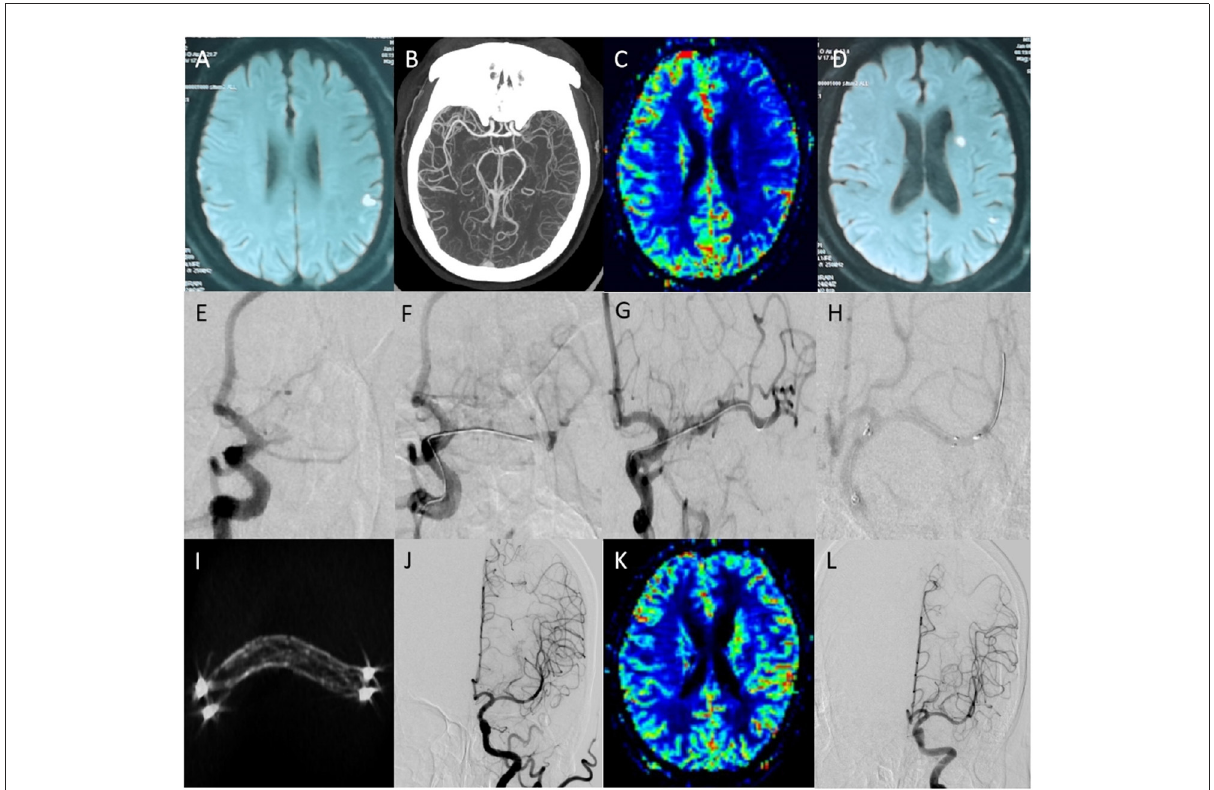
FIGURE1 Clinical data of a low-risk patient. Male patient, 65 years old; chief complaint: right limb weakness with slurred speech for 21 days, relapsed for 3 days; past medical history: hypertension for 6 years; physical examination: the right limb muscle strength was grade 3, and the muscle tone was normal; the mRS score was 2. (A) Preoperative magnetic resonance imaging (MRI) shows acute cerebral infarction in the left cerebral parietal lobe. (B) Computed tomography angiography shows the M1 segment occlusion of the left middle cerebral artery. (C) Preoperative perfusion-weighted imaging (PWI) shows left cerebral hypoperfusion. (D) MRI after symptom recurrence shows left basal ganglia and parietal lobe acute cerebral infarction. (E) Preoperative digitally subtracted angiography (DSA) shows the left middle cerebral artery occlusion (occlusion length < 5mm, occlusion duration < 3 months, atherosclerotic, no calcification, straight). (F) The micro-guide wire passed through the occluded segment during the operation. (G) The Gateway 2.0 × 10mm balloon was used for accurate positioning and 4ATM expansion. (H) Neuroform 3.5 × 20mm was ascended along the stent catheter, accurately positioned, and released. (I) The reconstructed stent is visible, and the stent is well expanded. (J) Postoperative anteroposterior angiography. (K) PWI shows that the bilateral perfusion was symmetrical, and the left cerebral perfusion was significantly improved. (L) Angiography was repeated 5 months later, which showed stent patency, and the mRS score was